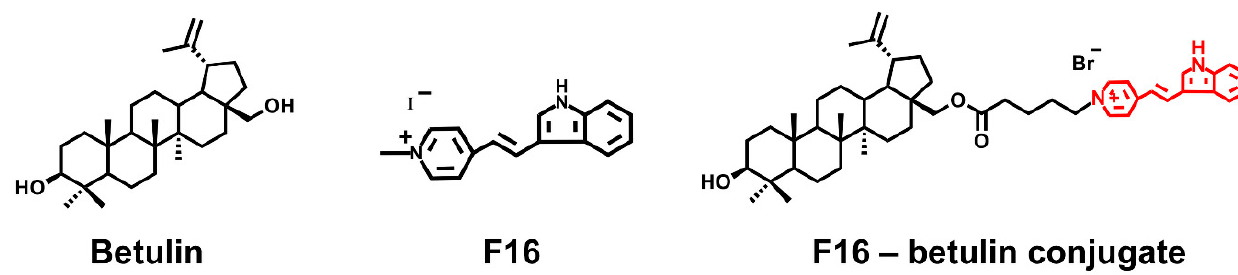
Figure 1. Structure of betulin, F16 ([E-4-(1H-indol-3-ylvinyl)-N-methylpyridinium iodide]) and of F16-betulin conjugate.